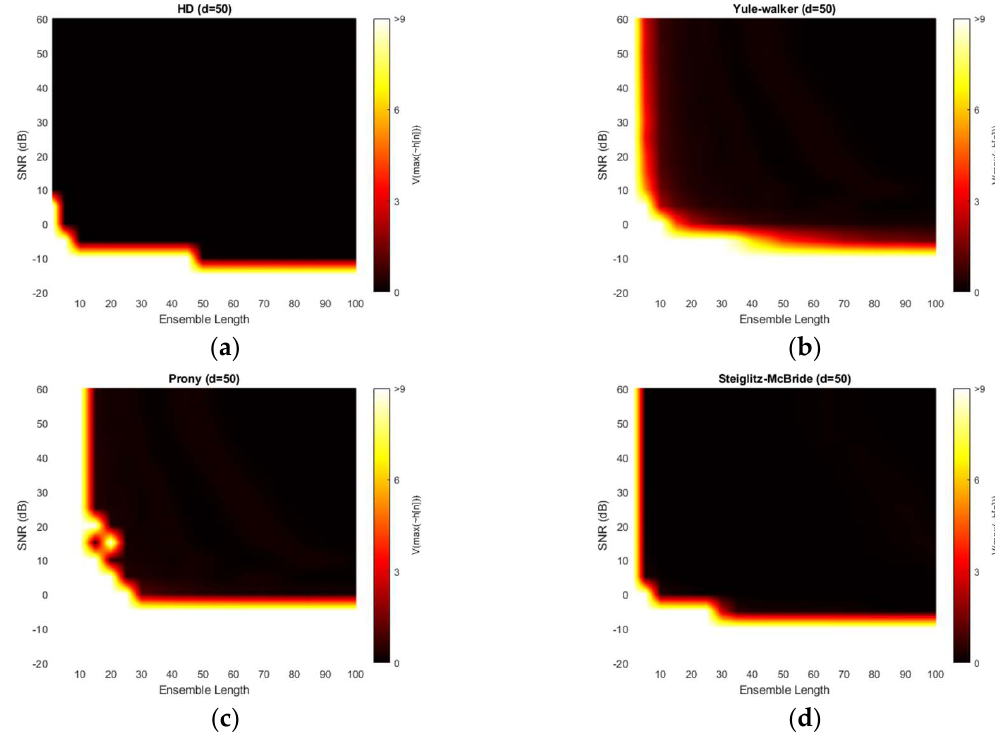
Figure 12. Variance of estimation with given ensemble average length & SNR for 50-sample delay: ( a ) non-parametric HD; ( b ) Yule-walker HD; ( c ) Prony HD; ( d ) Steiglitz-McBride HD.